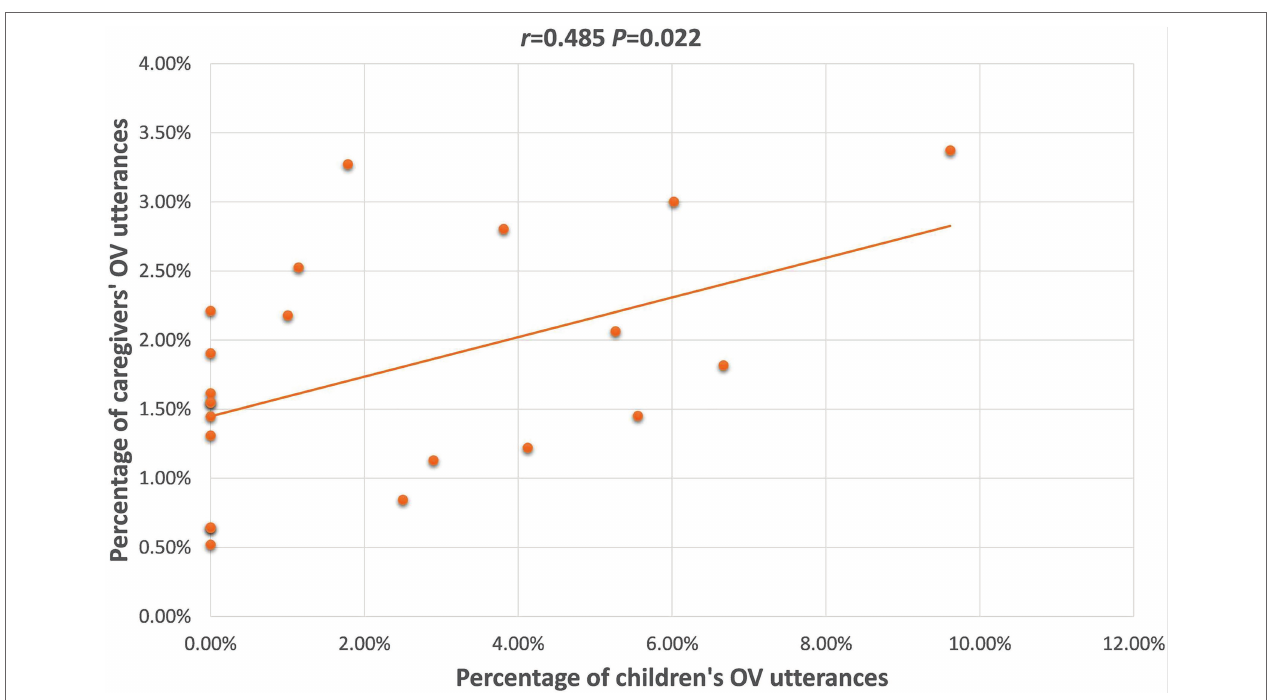
FIGURE 4 | Scatterplot of children with ASD’s and caregivers’ OV utterances, combined across